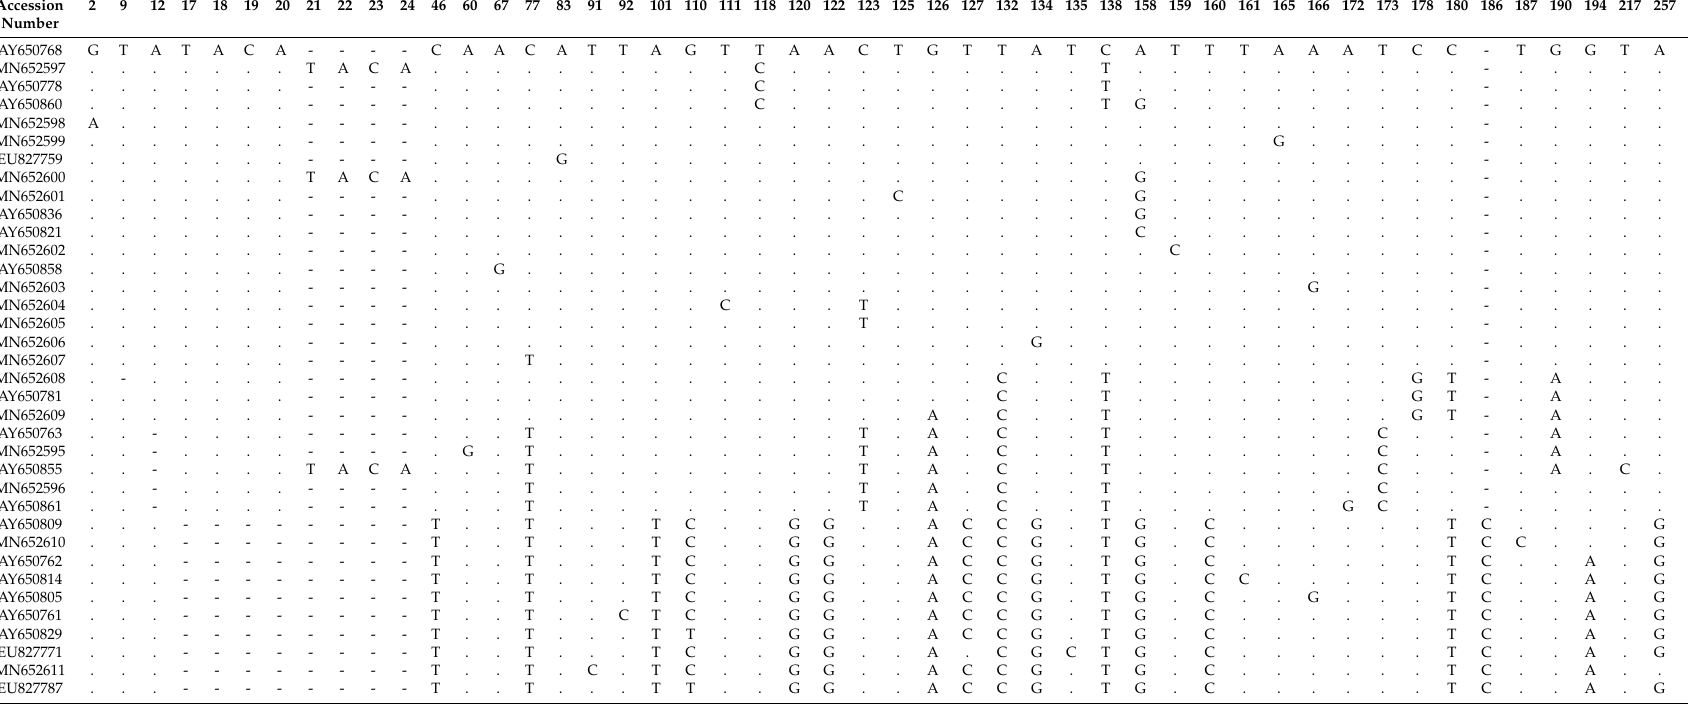
Table 2. Variable sites in the control-region segment of the 36 haplotypes of swordfish mtDNA detected in the modern sample. Numbers above sites refer to nucleotide position on the L-strand of the control region of the swordfish. Identity with sequence 1 is indicated by dots and deletions of 1 residue with